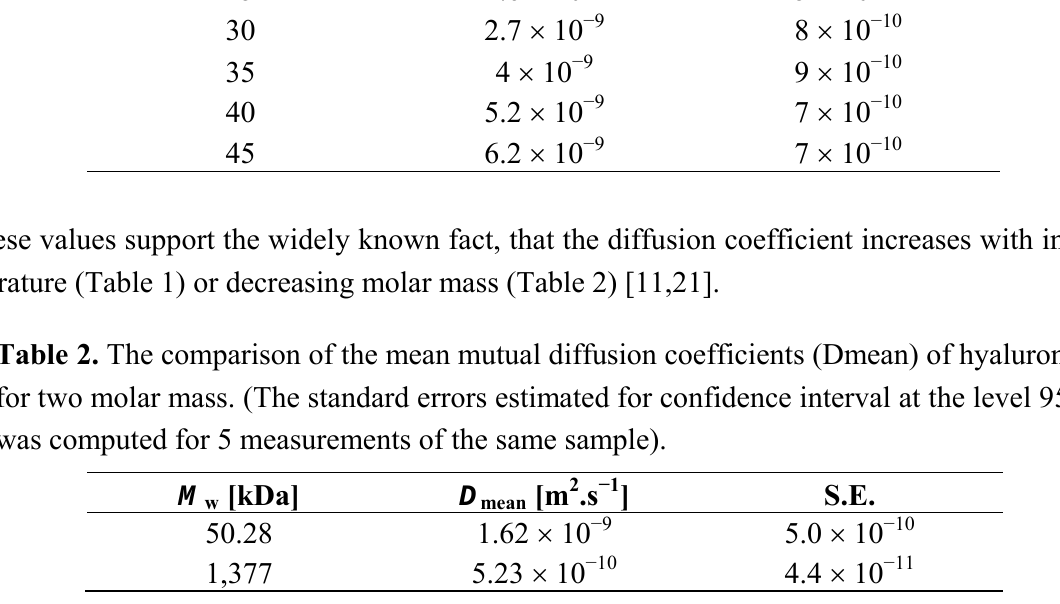
) of hyaluronan (M = 50.28 kDa) mean w